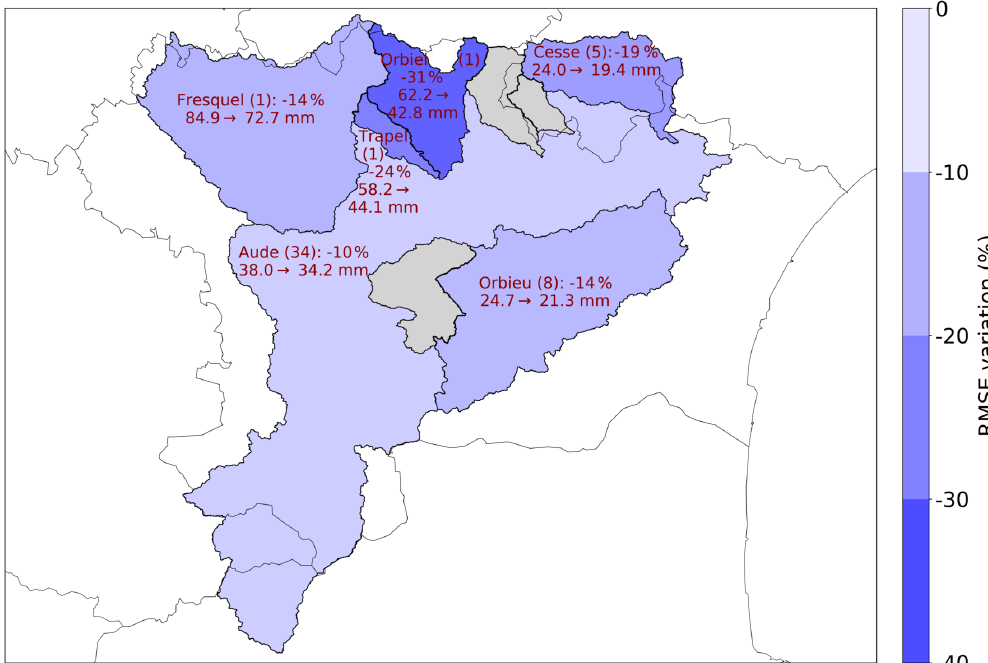
Figure A2. RMSE variation (% and mm) between SPWS ANTILOPE and SWS ANTILOPE over validation rain gauges in each watershed of the Aude basin. The name of the watershed and the number of validation rain gauges (in parentheses) are indicated. Grey watersheds indicate that no validation rain gauges are